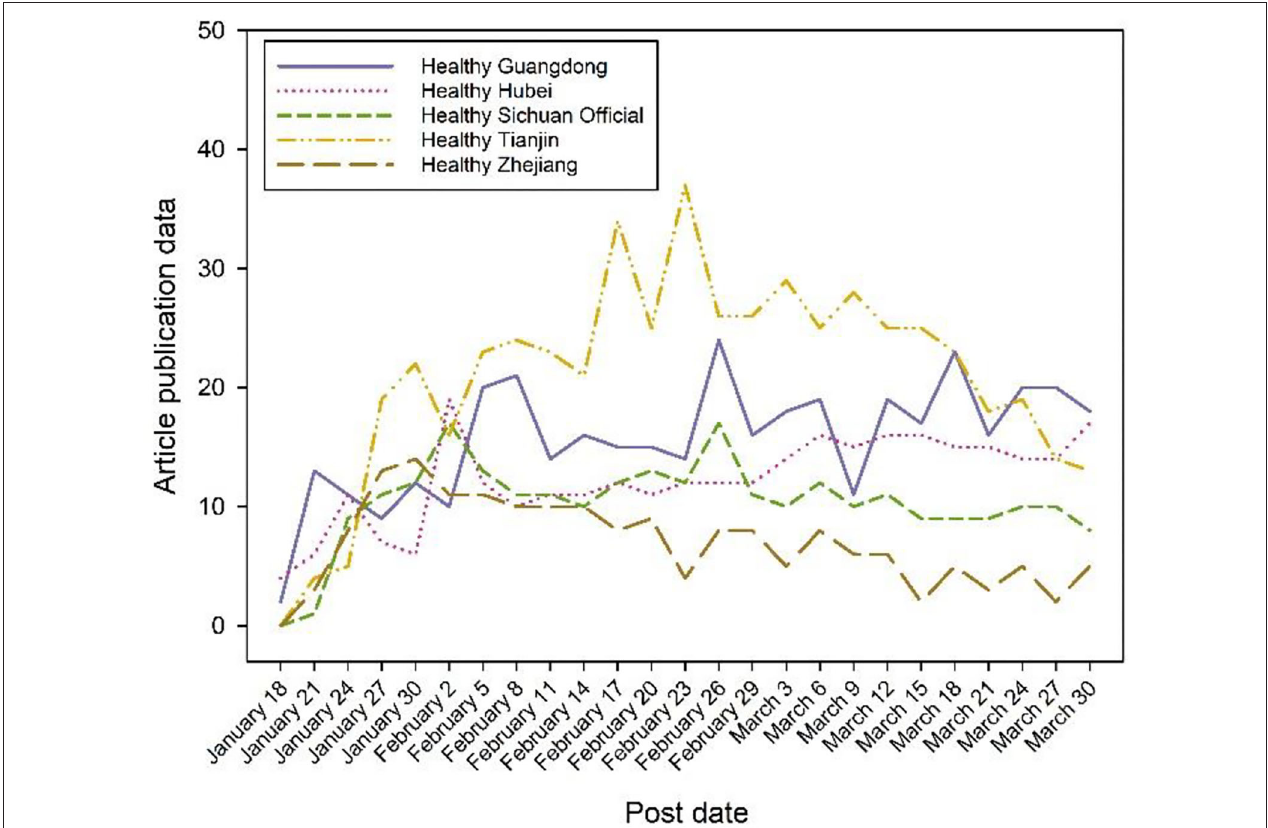
FIGURE 3 | Daily trend of the number of tweets from different WeChat official accounts.